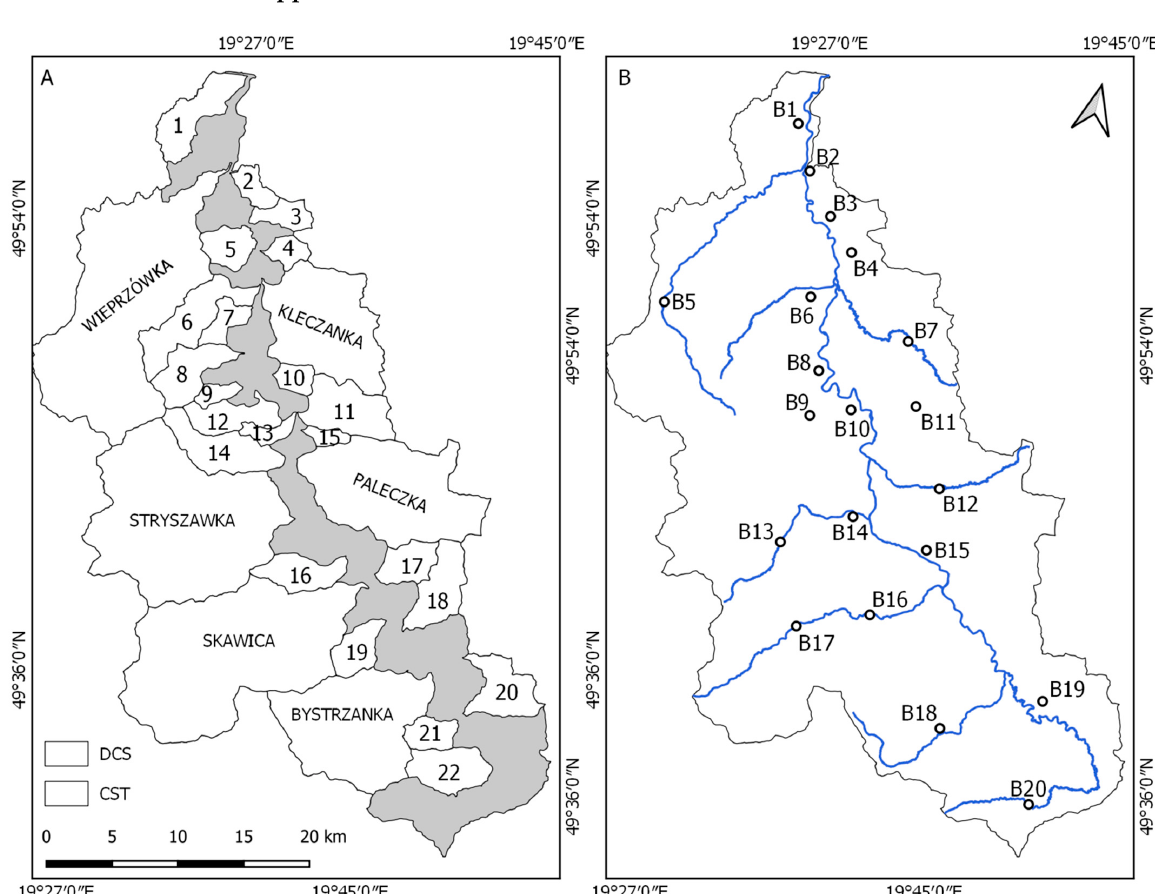
Figure A1. Research area. ( A ). Catchments of the Skawa tributaries: DCS—the direct catchment of the Skawa; CST—Skawa tributaries catchment with an area of more than 4 km 2 : 1— Ł owiczanka,